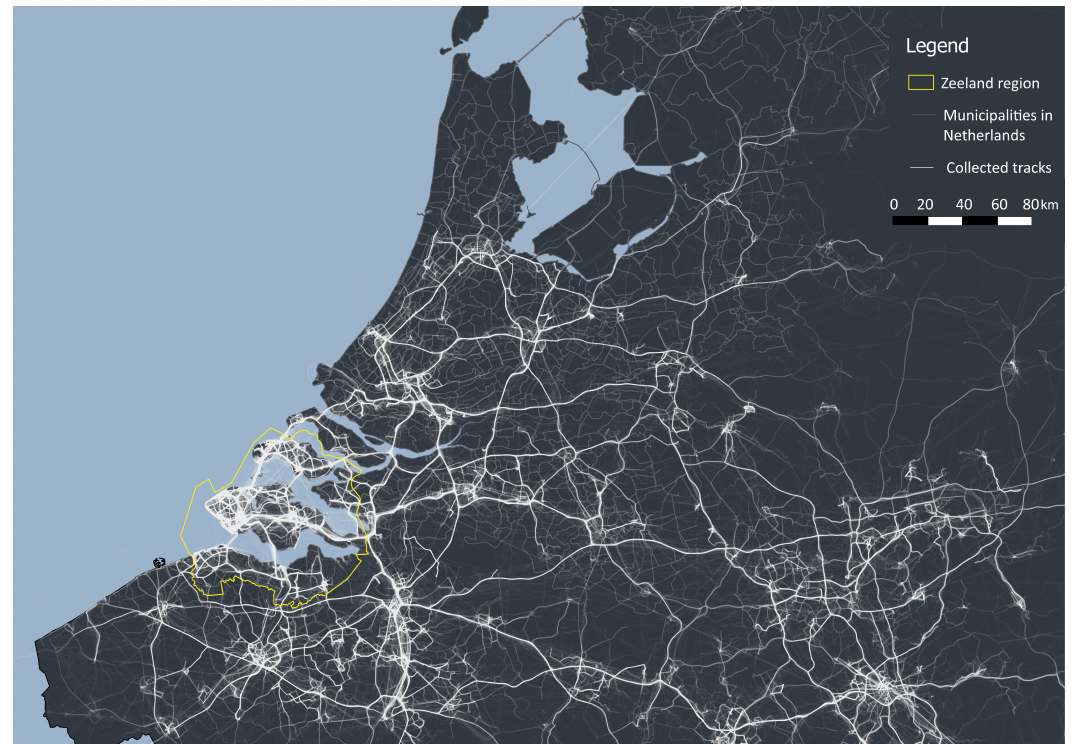
Figure 3. Data collected by the Zeeland mobile